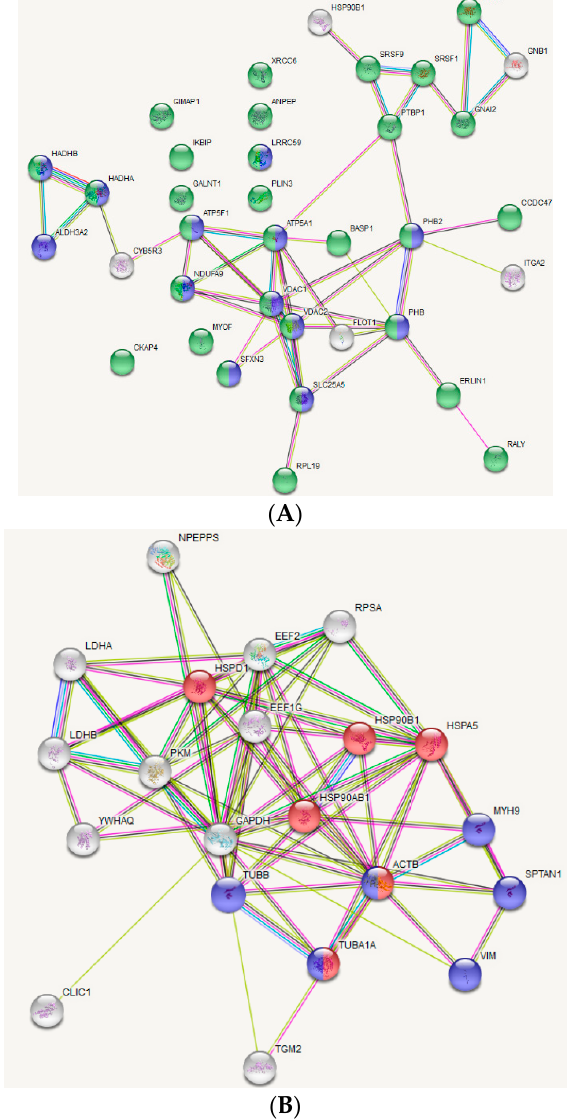
Figure 6. STRING analysis of proteins identified as targets of OxPAPC from the PBS-insoluble/RIPA-soluble fraction ( A ) and from the PBS-soluble fraction ( B ). The RIPA-soluble fraction of modified proteins contains mainly proteins located at membrane organelles (green nodes: membrane-bounded organelle; GO: 0043227). Furthermore, several modified proteins are located at the mitochondrial membrane (blue nodes: mitochondrial part; GO: 0044429). In the PBS-soluble fraction, proteins related to protein folding (red nodes: protein folding; GO: 0006457) and proteins related to the cytoskeleton (blue nodes: structural constituent of cytoskeleton; GO: 0005200) are enriched.